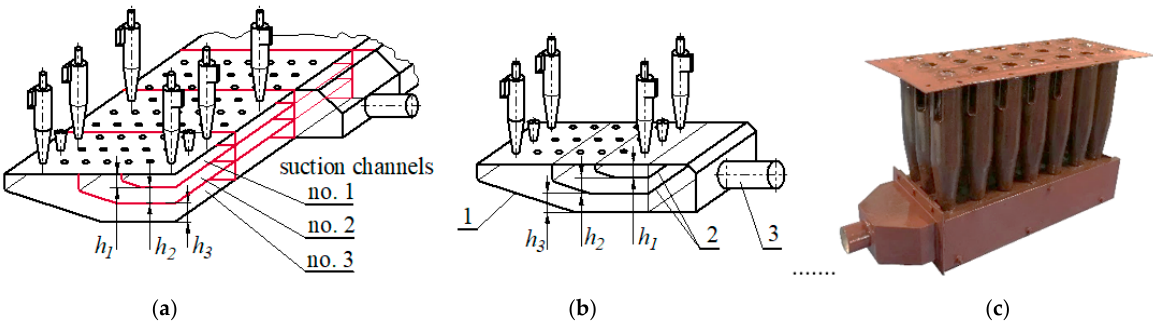
Figure 16. Dust settler schematic diagram: ( a ) MT multi-cyclone, ( b ) MT multi-cyclone segment, ( c ) segment prepared for flow tests, 1—sedimentation tank, 2—horizontal partitions, 3—suction port.